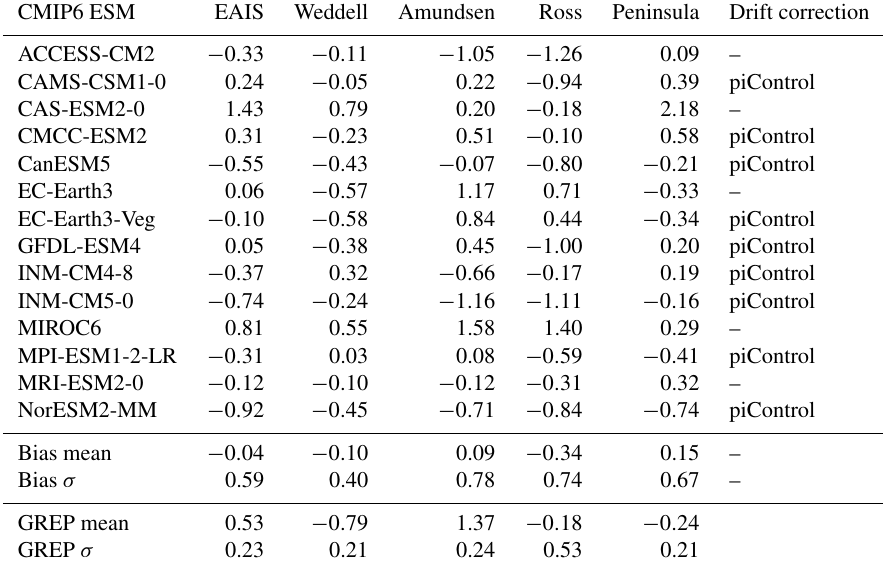
Table 1. CMIP6 ESMs that have been evaluated. For each sector the subsurface ocean temperature bias (in K) compared to the GREP reanalysis is indicated over the period 1993–2018, including years 2015–2018 for the SSP2-4.5 scenario. The “drift correction” column indicates whether the piControl experiment was used for model drift correction. The bottom four rows show the mean and standard deviation ( σ ) of the ESM biases in K) and the mean ocean temperature (in ◦ C) and standard deviation of the GREP reanalysis product.